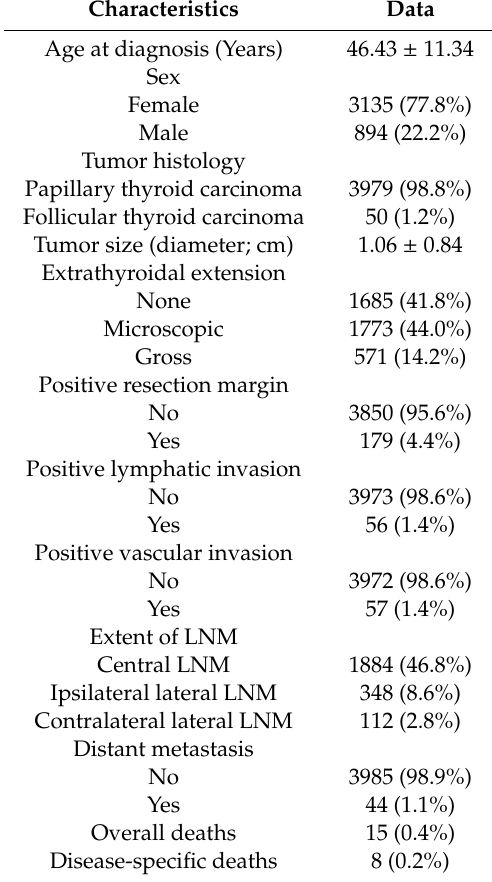
Table 1. Baseline characteristics of patients included in the